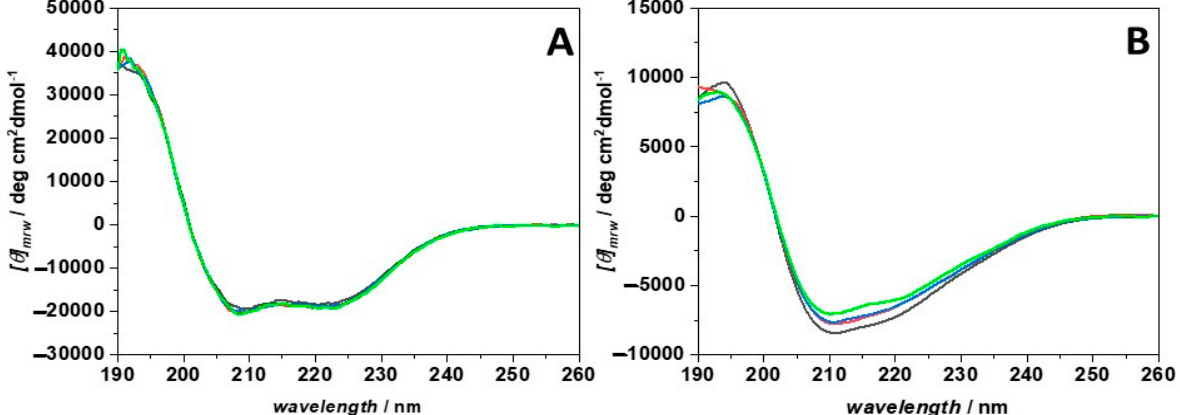
Figure 5. Far UV-CD spectra of ( A ) HSA and ( B ) hTf recorded in the absence (black spectra) and in the presence of increasing concentrations of DoHuRu/DOTAP. The concentrations of both proteins were 1.5 µ M. For HSA, the vesicles concentrations were 45 µ M (red spectrum), 75 µ M (blue spectrum), and 150 µ M (green spectrum). For hTf, vesicles concentrations were 1.5 µ M (red spectrum), 15 µ M (blue spectrum) and 75 µ M (green spectrum). The spectra were recorded at 20 ◦ C by using a 0.1 cm path length quartz cuvette.